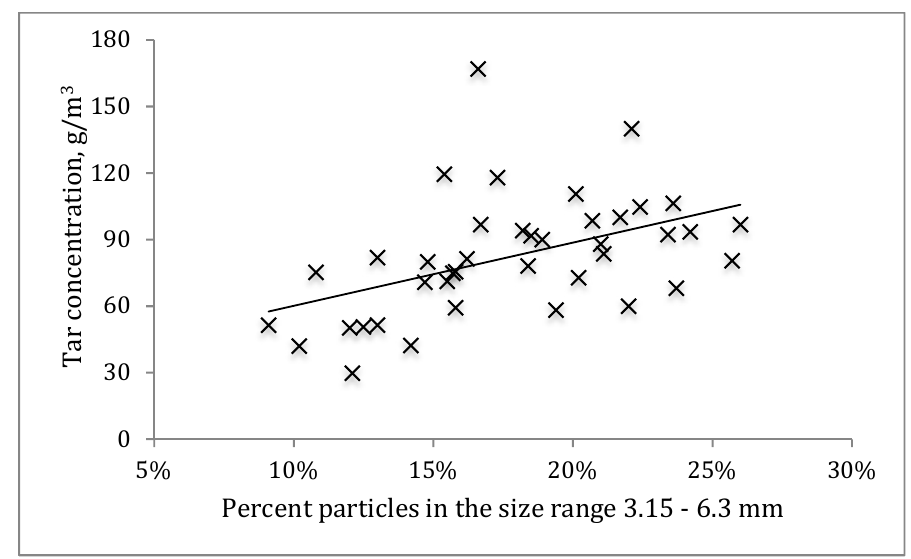
Figure 8. Tar concentration vs. percent particles with a smaller size range Tests done at the UBC gasifier.